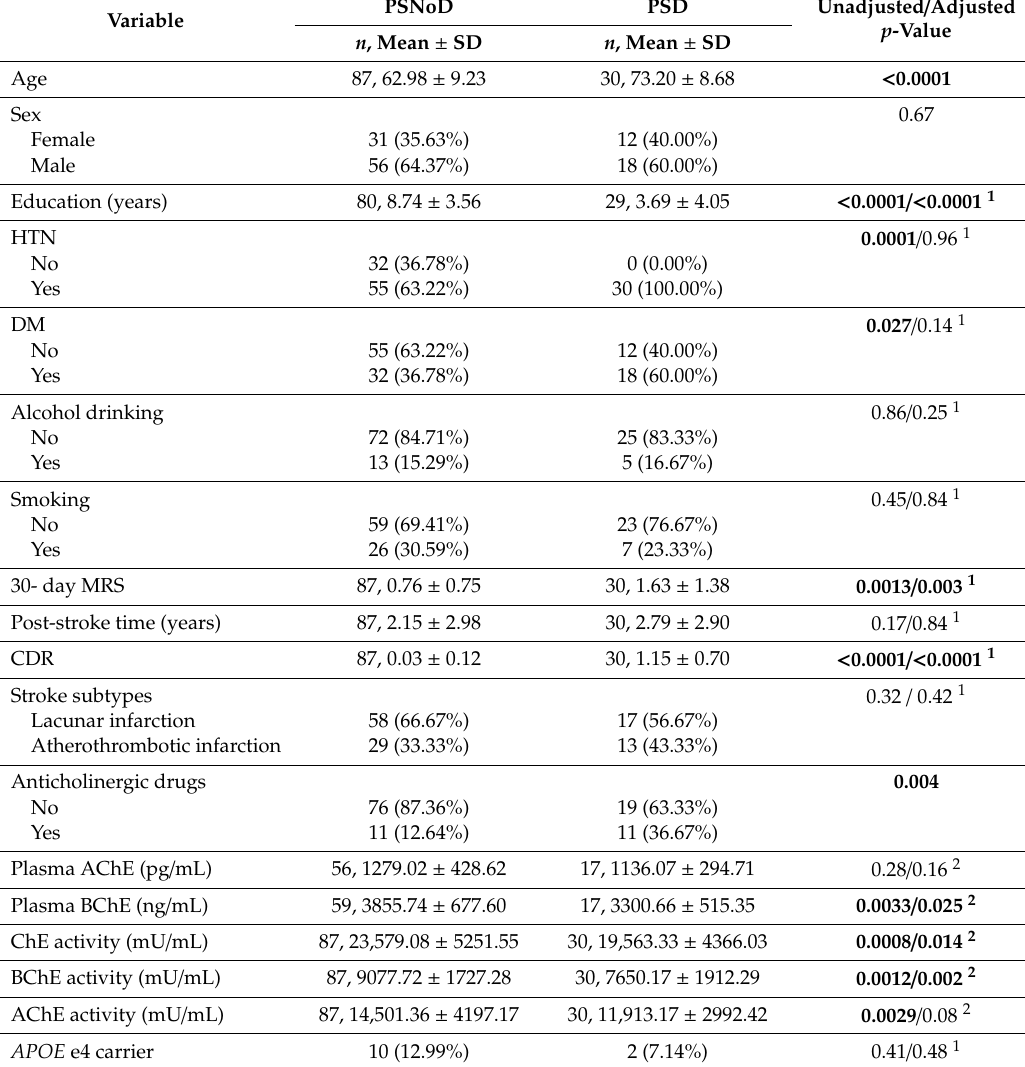
Table 2. Association analyses among ischemic stroke patients with or without